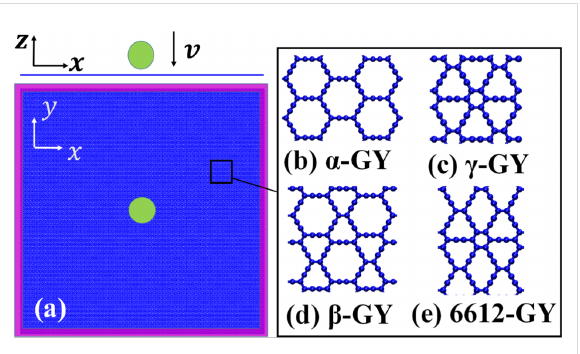
Figure 1: Schematic view of the impact simulation setup. (a) Top: side view and bottom: top view. The red regions represent the fixed bound- aries during impact; atomic configurations of: (b) α -GY; (c) γ -GY; (d) β -GY; and (e)